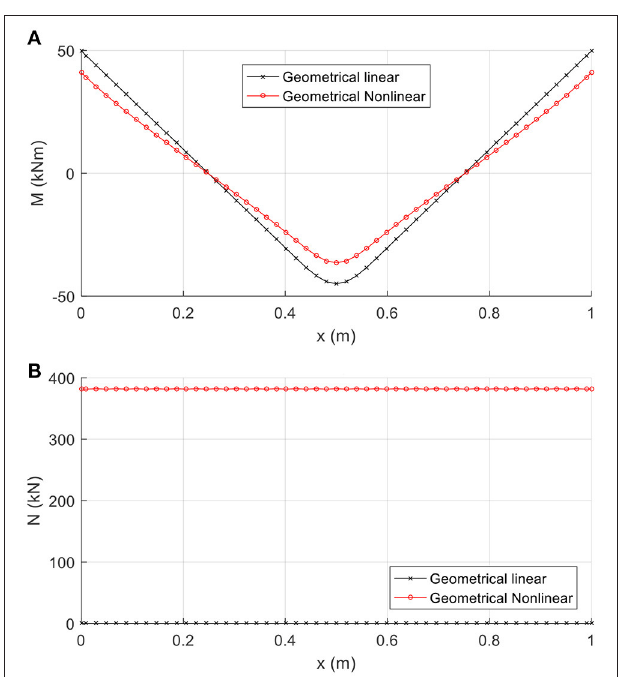
FIGURE 14 | Profile of the (A) bending moment, and (B) axial force, for P z = 400 kN in Example